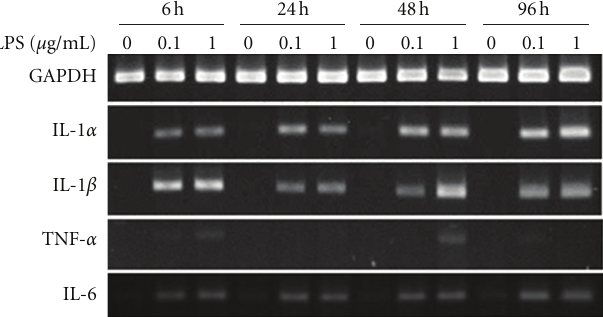
Figure 6: Expression of pro-inflammatory cytokine genes in rat stromal bone marrow cells. Gene expression for IL-1 α , IL-1 β , TNF- α , IL-6 and GAPDH in rSBMCs cultures in the presence and absence of LPS. The LPS concentrations used were 0.1 μ g/mL and 1 μ g/mL. RNA was isolated at 6, 24, 48 and 96 hours. RT-PCR was carried out at 30 cycles for GAPDH, IL-1 α , IL-1 β , and TNF- α , and 25 cycles for